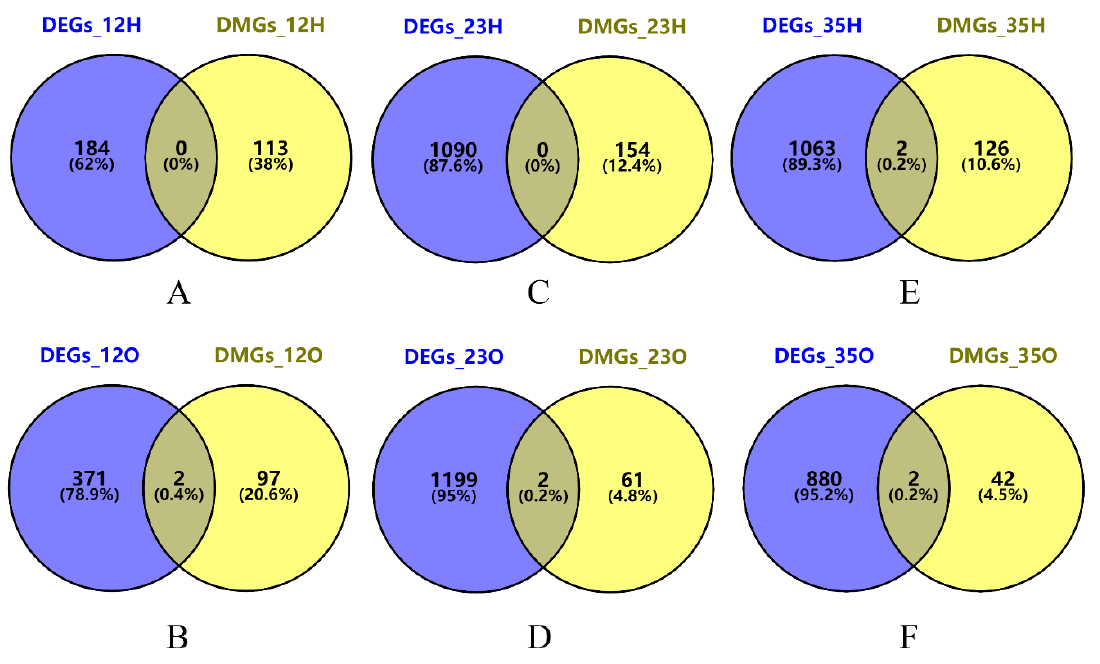
Figure 5. Venn diagram showing six common candidate DEGs and DMGs. DEGs_12H ( A ) and DMGs_12H ( A ) mean the DEGs and DMGs respectively from the hypothalamus in 1-vs.-2 groups; DEGs_12O ( B ) and DMGs_12O ( B ) mean the DEGs and DMGs respectively from the ovary in 1-vs.-2 groups; DEGs_23H ( C ) and DMGs_23H ( C ) mean the DEGs and DMGs respectively from the hypothalamus in 2-vs.-3 groups; DEGs_23O ( D ) and DMGs_23O ( D ) mean the DEGs and DMGs respectively from the ovary in 2-vs.-3 groups; DEGs_35H ( E ) and DMGs_35H ( E ) mean the DEGs and DMGs respectively from the hypothalamus in 3-vs.-5 groups; DEGs_35O ( F ) and DMGs_35O ( F ) mean the DEGs and DMGs respectively from the ovary in 3-vs.-5 groups. Table 2. Transcriptional level, methylation state, and function of common DEGs and DMGs in different groups.